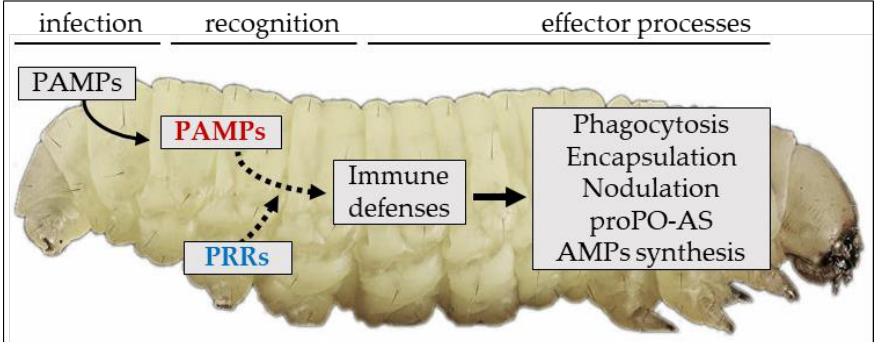
Figure 5. After entry, PAMPs interact with hemolymph and cell-membrane receptors (PRRs) triggering humoral and cellular defenses of the insect host.